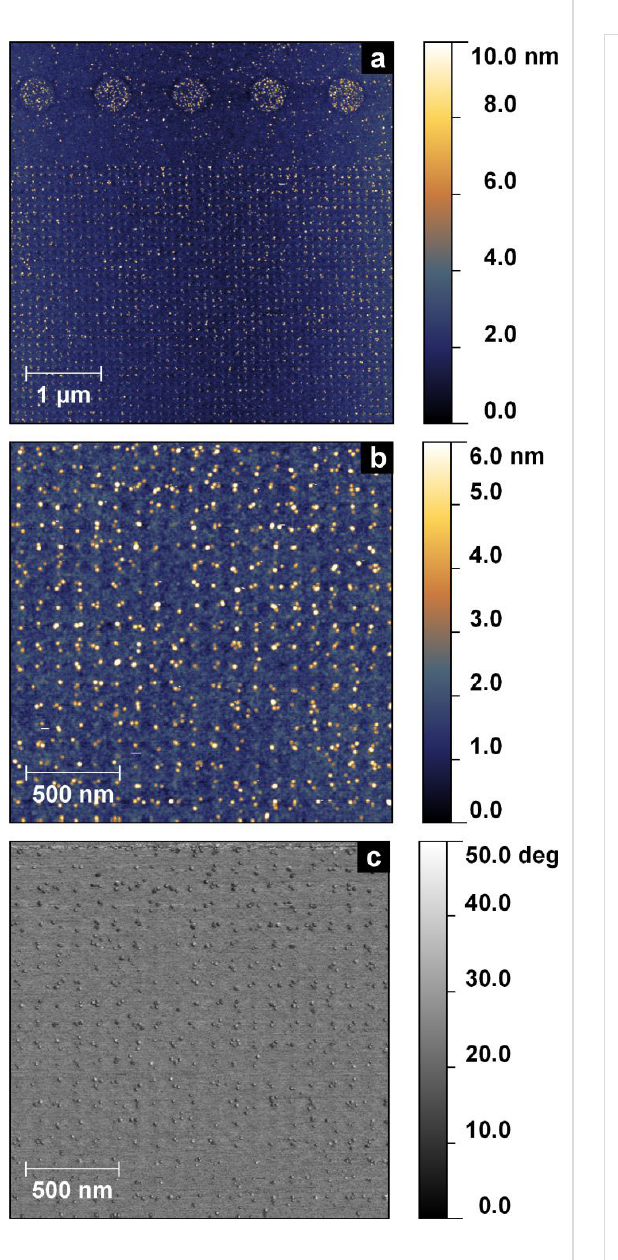
Figure 7: AFM measurements of height (a, b) and phase (c) of a CSPETCS SAM patterned by pointwise irradiation with electrons after incubation with citrate-stabilised 6 nm AuNP.